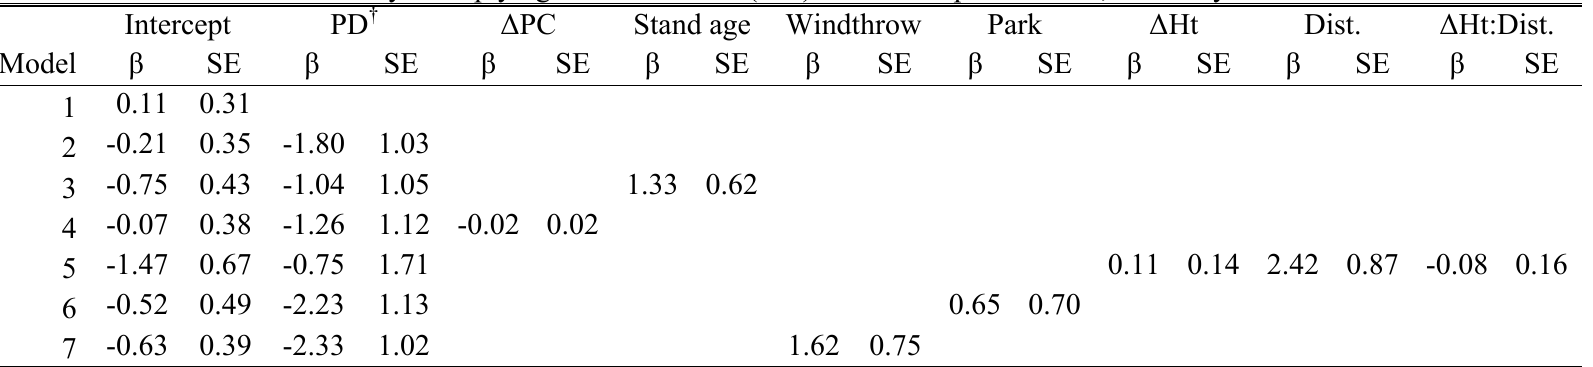
Table A2.6 Parameter estimates for models examining variation in stand-level trends (between circa 1994 and 2014) in abundance Mourning Warbler in aspen dominated mixedwood forests in central Saskatchewan. 85% Confidence Intervals can be obtained as β ± 1.44* SE. NOTE: Parameter values were rescaled by multiplying with a constant (100) for ease of presentation, divide by 100 to obtain estimates.